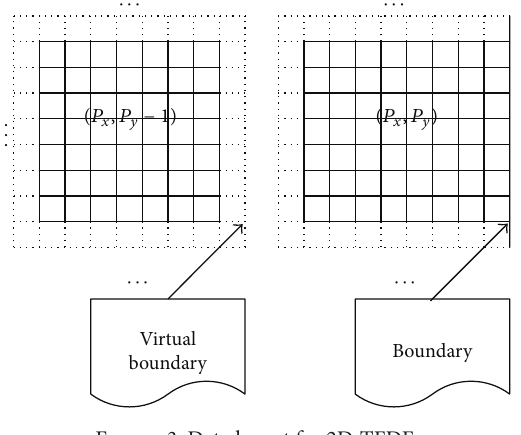
Figure 3: Data layout for 2D-TFDE.